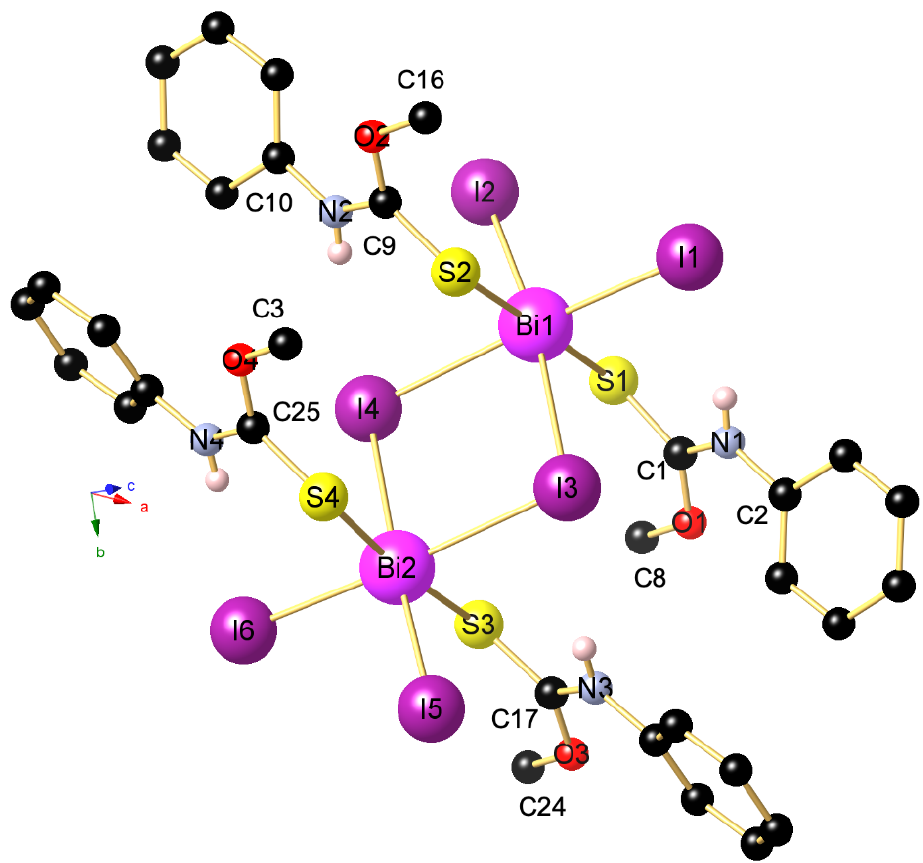
Figure 2. Molecular structure of 1 . Selected bond lengths (Å) and angles (deg) of 1. Bi1–I1